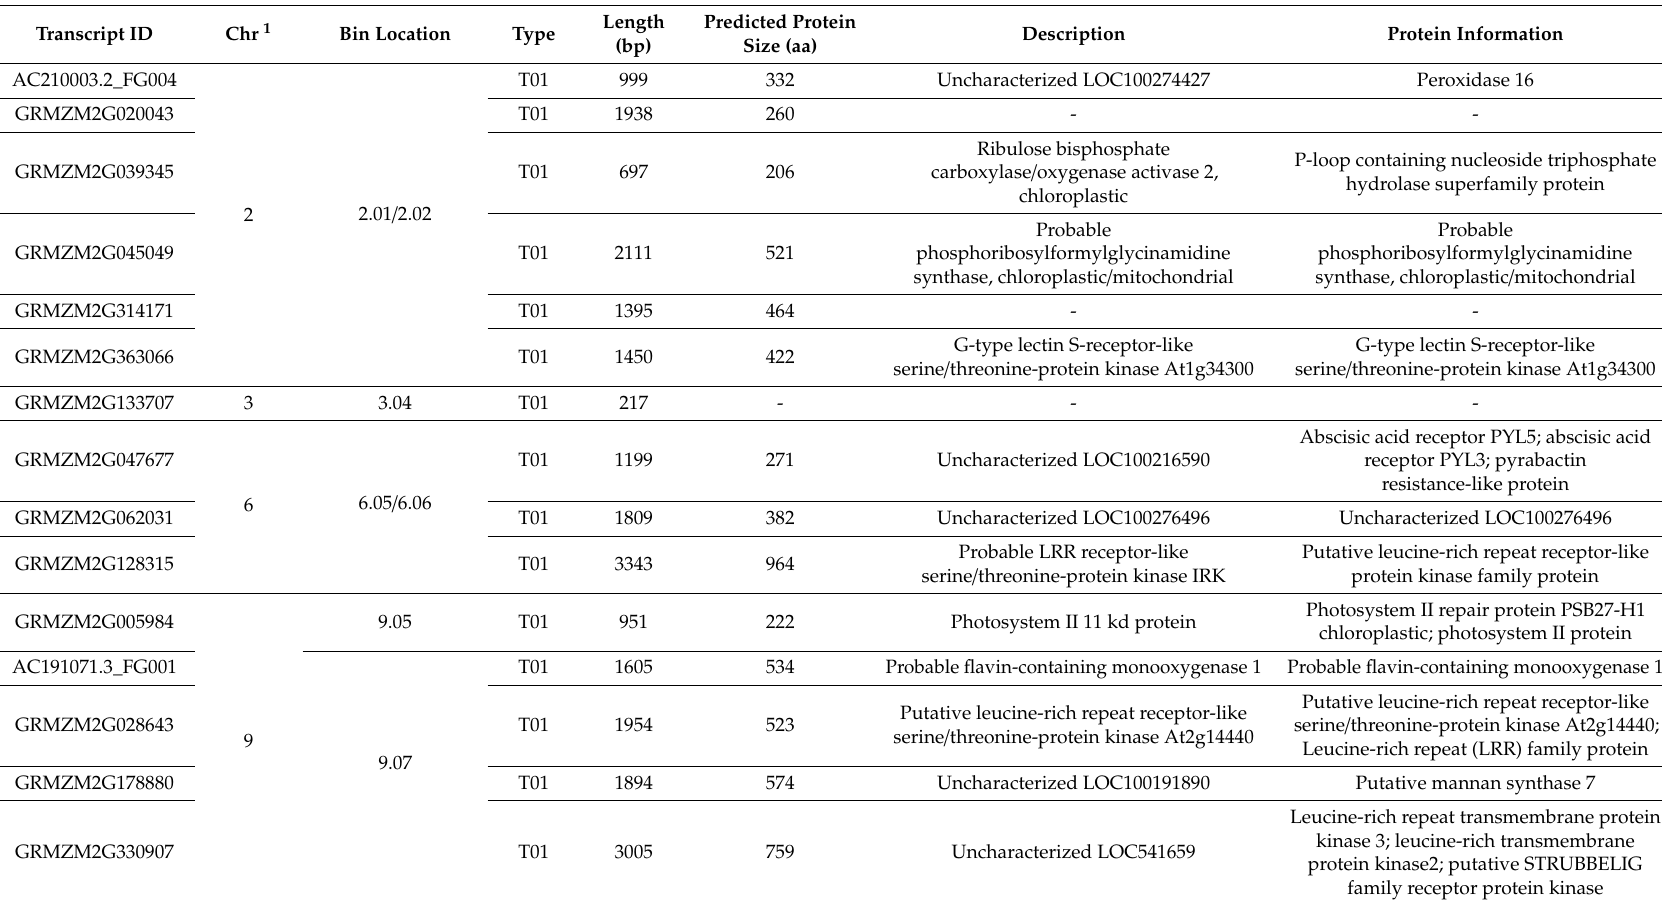
Table 5. List of the P. sorghi, P. maydis, and S. macrospora resistance candidate genes between the left and right flanked